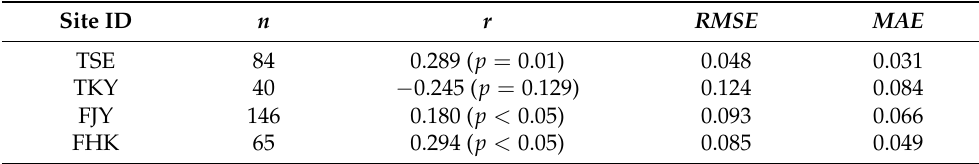
Figure 8. Scatter plots between PRI satellite and PRI simulated . PRI satellite was screened with the QA flag (QA = 2). The dotted line represents the 1:1 line. The black solid line is the linear regression line. The shape of each point represents the year: the circle is 2018, the triangle is 2019, and the square is 2020. The color of each point corresponds to the DOY. Table 6. The statistics of the accuracy assessment between PRI satellite and PRI simulated . n is the sample size, r is the coefficient of correlation, RMSE is the root mean square error, and MAE is the mean absolute error. Site